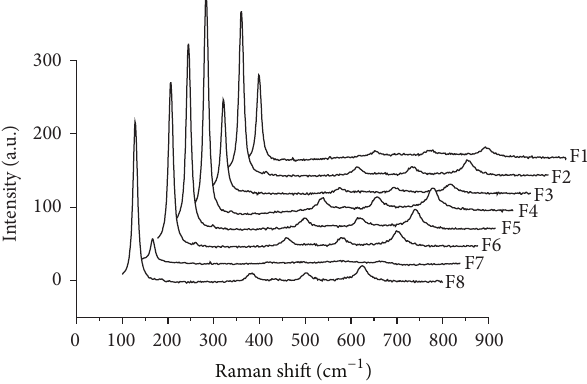
Figure 1: Raman spectra of TiO 2 films formed using the 2 3